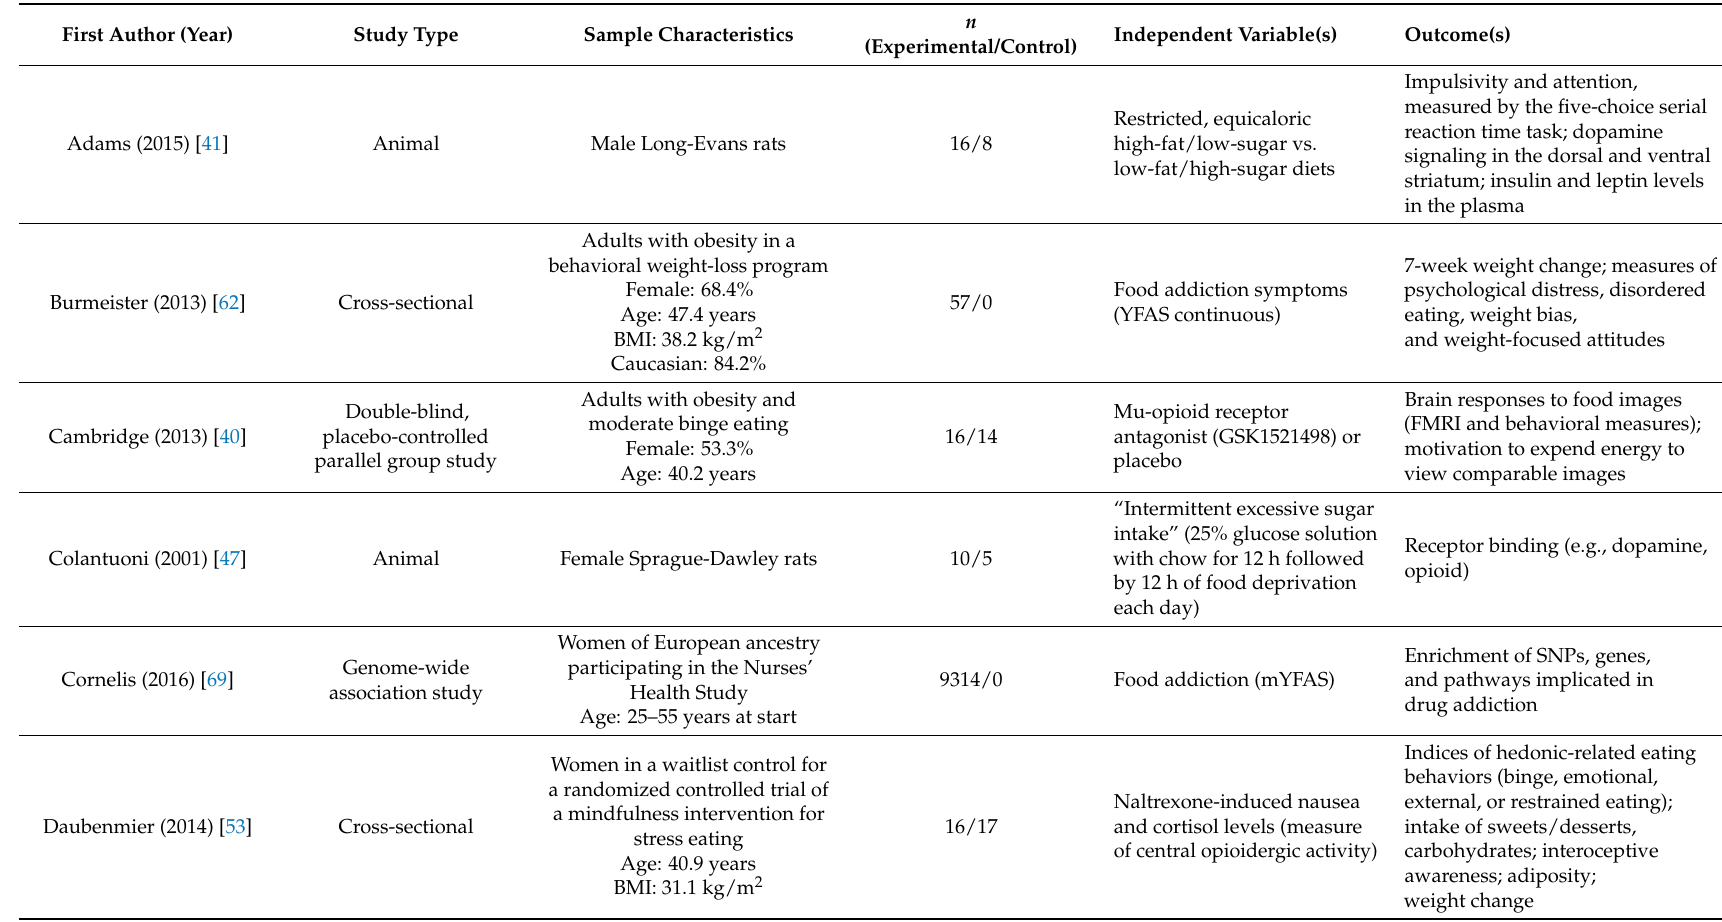
Table A1. Characteristics of included